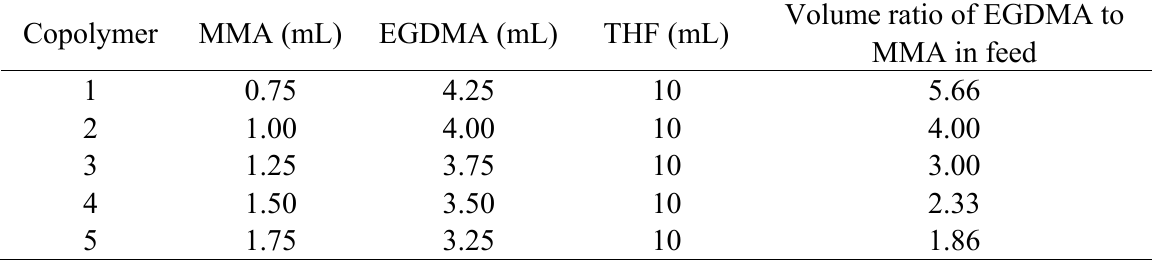
Table 1. Monomer Feed Preparations.